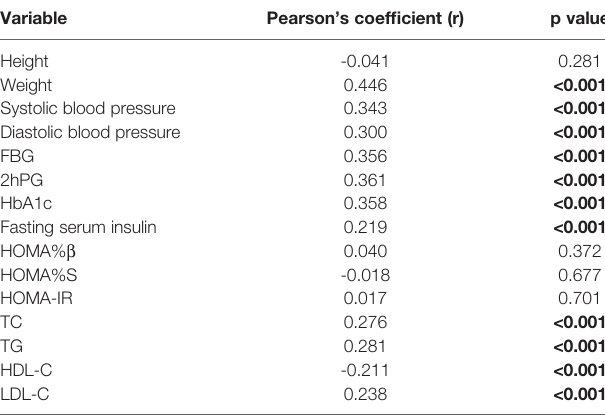
FBG, fasting blood glucose; 2hPG, 2-h plasma glucose; HOMA% b , homeostasis model assessment of b -cell function; HOMA%S, homeostasis model assessment of insulin sensitivity; HDL-C, high-density lipoprotein cholesterol; LDL-C, low-density lipoprotein cholesterol; HbA1c, glycated hemoglobin; TG, triglycerides; TC, total cholesterol. Bold P values indicate a signi fi cant difference.